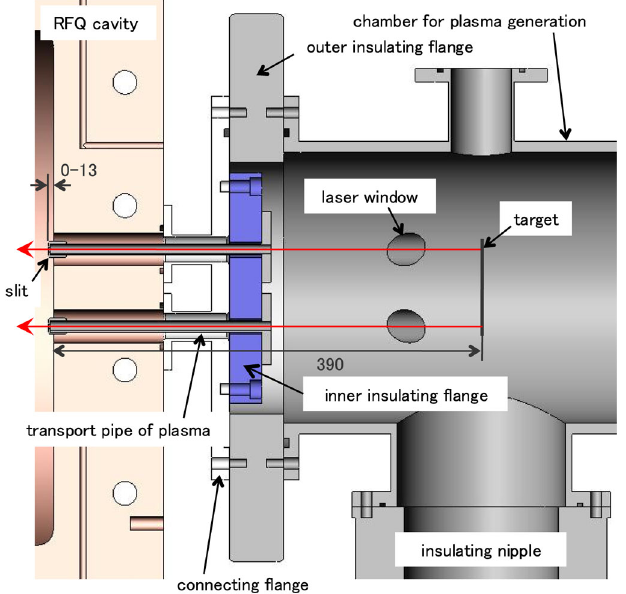
FIG. 26. Cross section of the two-beam laser ion source.